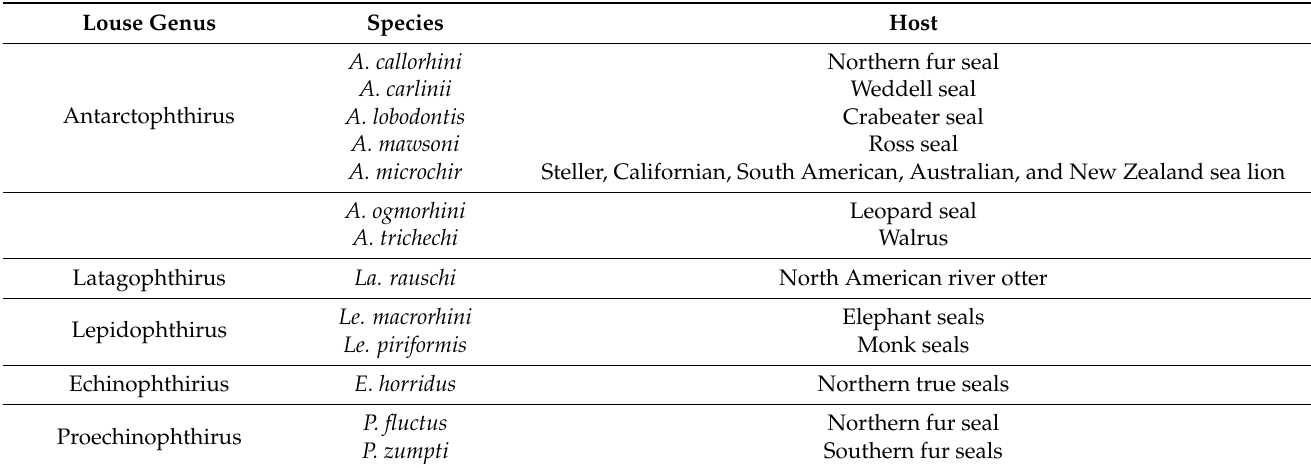
Table 1. Seal-louse associations of the family Echinophthiriidae (Anoplura).